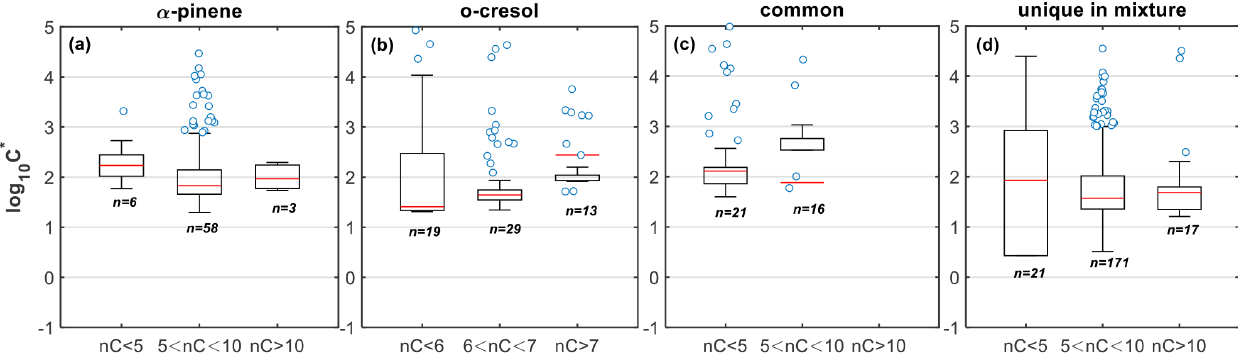
Figure 7. Box plots of the estimated volatility (log 10 C ∗ ) of the products identified in the mixture and were classified as products of (a) α - pinene, (b) o -cresol, (c) common, and (d) unique to the mixture, weighted to their contributions to the total particle-phase signal and grouped based on their number of carbon atoms. Red lines represent the median values, each boxes’ upper and lower limits represent the 75th and 25th percentiles, respectively, while the error bars represent the minimum and maximum values. The open circles show the individual compounds that were classified as outliers outside the interquartile range times